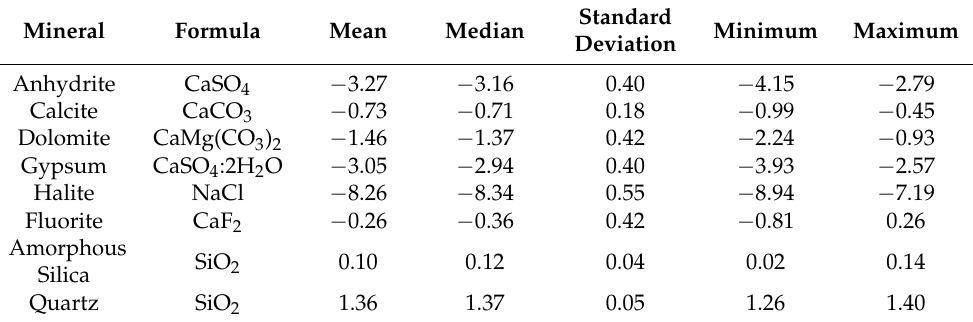
Table 4. Summary statistics of saturation indices (SI) of various minerals